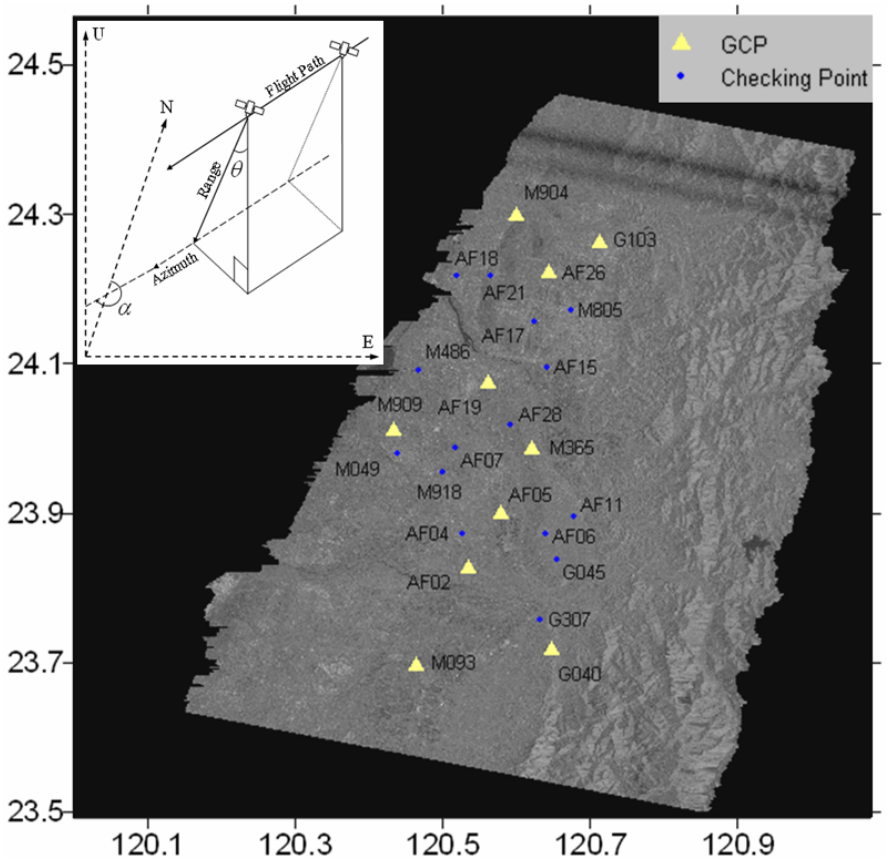
Figure 4. GPS stations used in the study. The yellow triangles represent the stations used as GCPs. The blue dots represent the stations used for validating the results. The inset diagram shows the geometry of radar image acquisition.